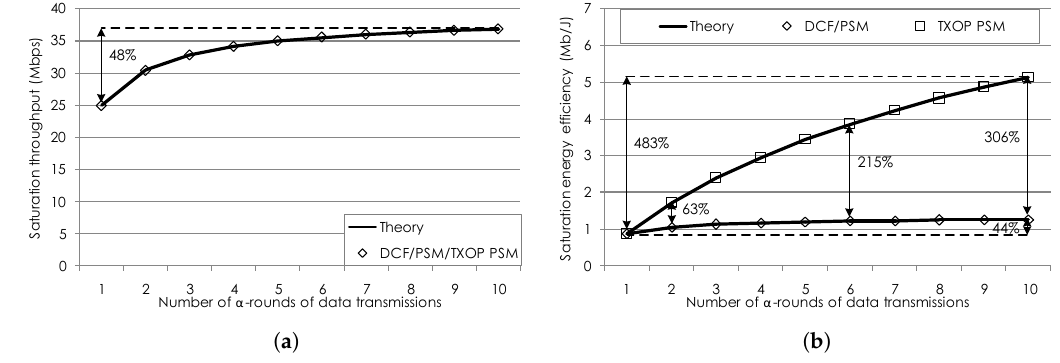
Figure 5. Saturation throughput and energy efficiency of the evaluated mechanisms as a function the number of α -rounds of data transmissions. ( a ) Saturation throughput. ( b ) Saturation energy